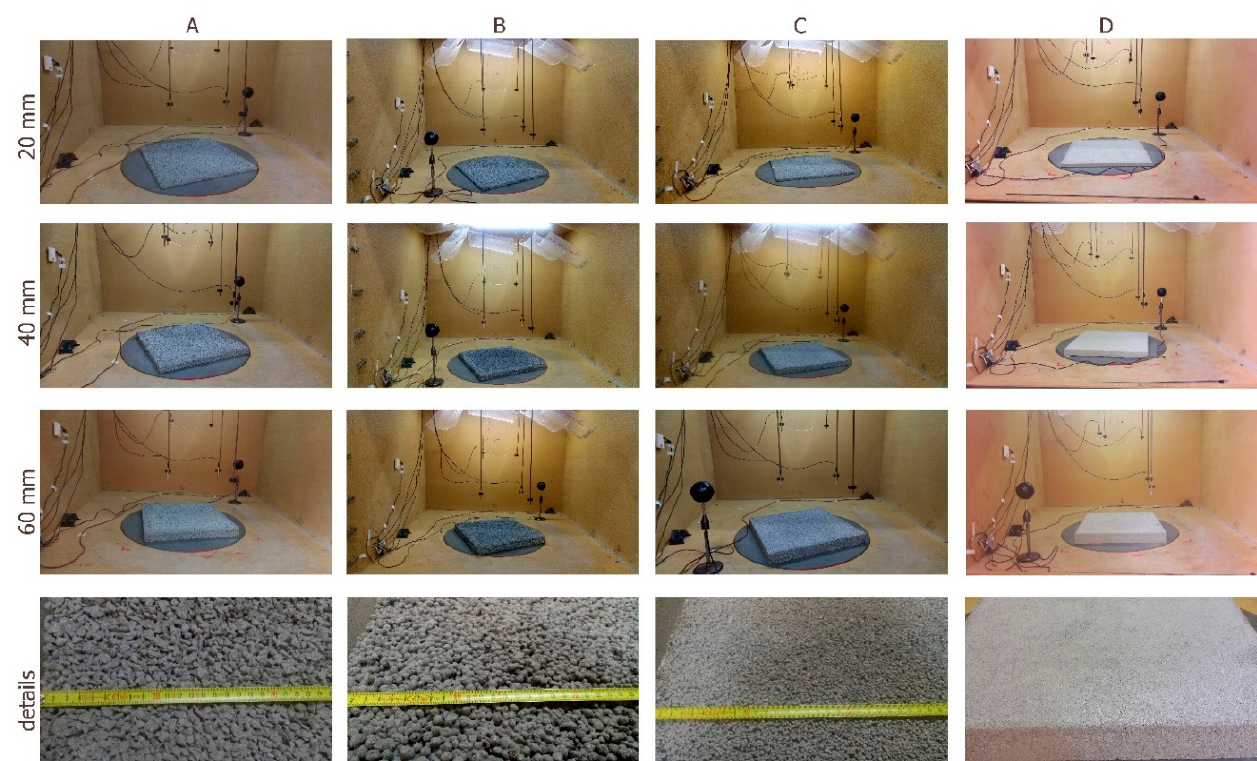
Figure 1. Sample ( A ): crushed normal weight aggregates 4–8 mm; Sample ( B ): round lightweight aggregates 4–8 mm; Sample ( C ): round lightweight aggregates 2–4 mm; Sample ( D ): round lightweight aggregates 0.5–1 mm.